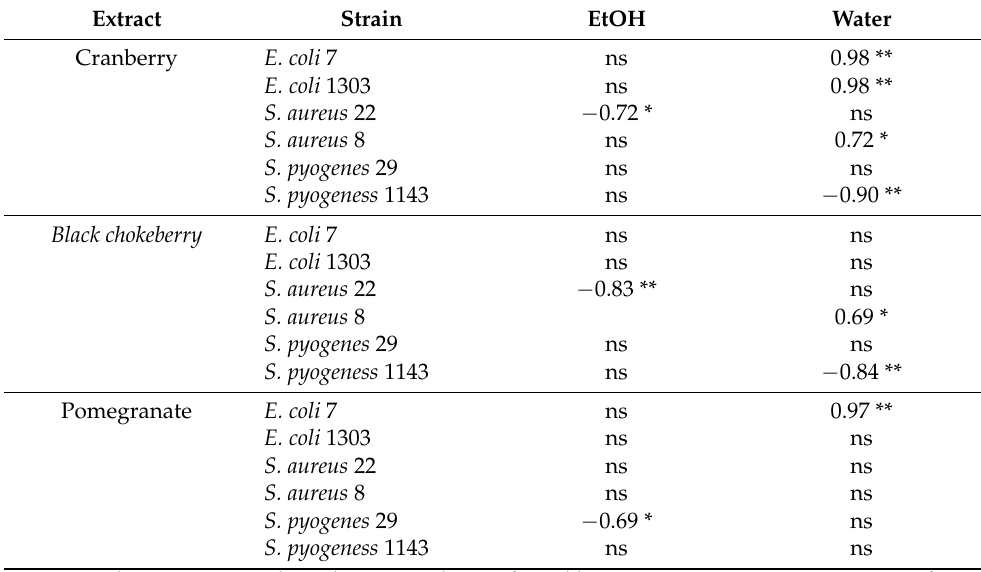
Table 5. Pearson correlation coefficients between solvent concentration (5%, 10%, and 20%) and effectiveness (zone of inhibition in mm) against pathogens for the various extracts. Extract Strain EtOH Water Cranberry E. coli 7 ns 0.98 ** E. coli 1303 ns 0.98 ** S. aureus 22 − 0.72 * ns S. aureus 8 ns 0.72 * S. pyogenes 29 ns ns S. pyogeness 1143 ns − 0.90 ** Black chokeberry E. coli 7 ns ns E. coli 1303 ns ns S. aureus 22 − 0.83 ** ns S. aureus 8 0.69 * S. pyogenes 29 ns ns ns − 0.84 ** Pomegranate E. coli 7 ns 0.97 ** E. coli 1303 ns ns S. aureus